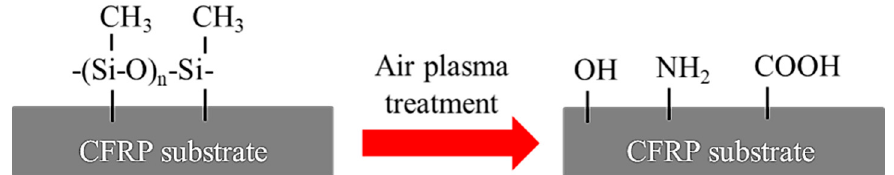
Figure 16. Activated groups and adhesive molecules forming bonding on the CFRP substrate surface.